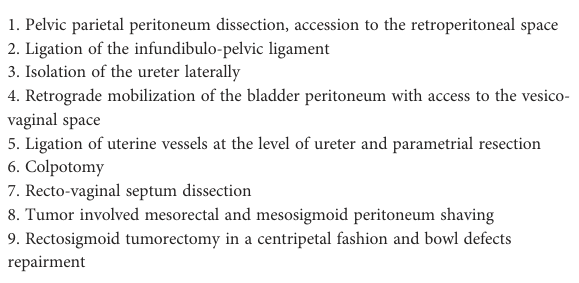
TABLE 1 Surgical steps of rectosigmoid sparing en bloc pelvic resection.